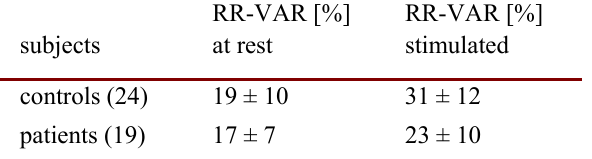
Table 3. Variability in RR-interval (RR-VAR) ± S.D. [%] in the group of patients with Parkinson’s disease and in the group of control subjects while breathing at rest and during stimulated, deep breathing at 0.1 Hz.